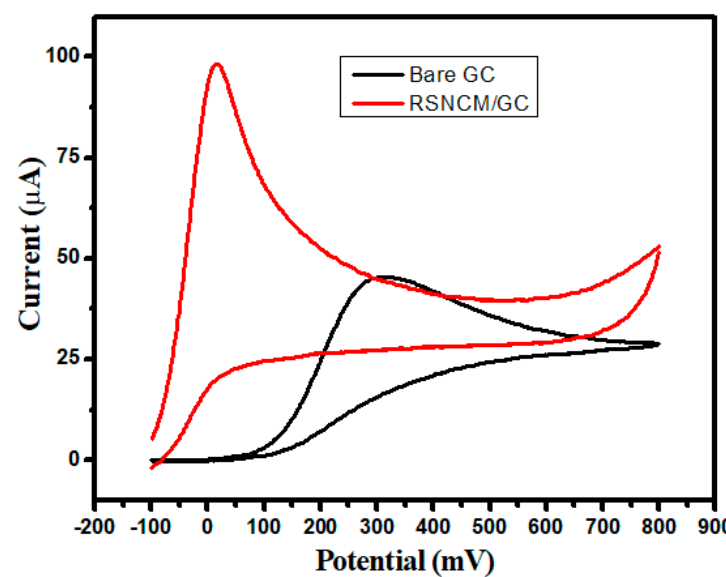
Figure 6. CVs obtained for RSNMC/GC and bare GC in 3 mM ascorbic acid prepared in PBS, pH 7.0 at scan rate of 20 mV/s.